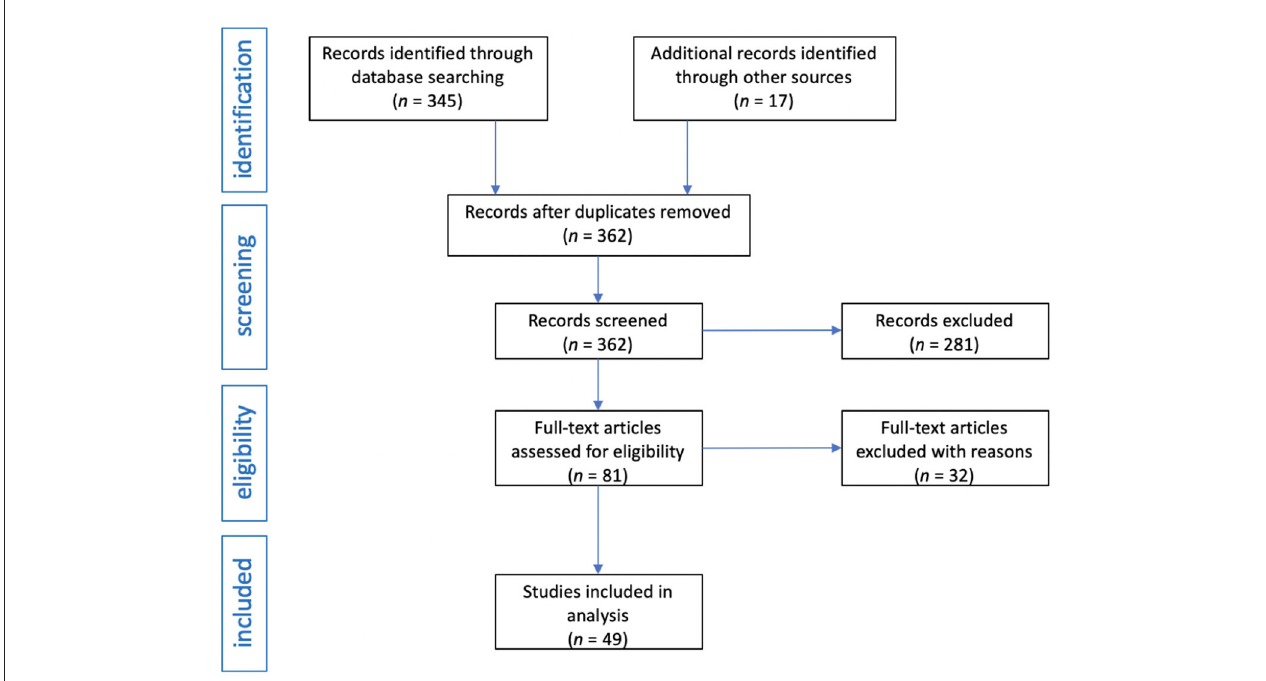
FIGURE 1 | Flow diagram of studies analysis and selection for